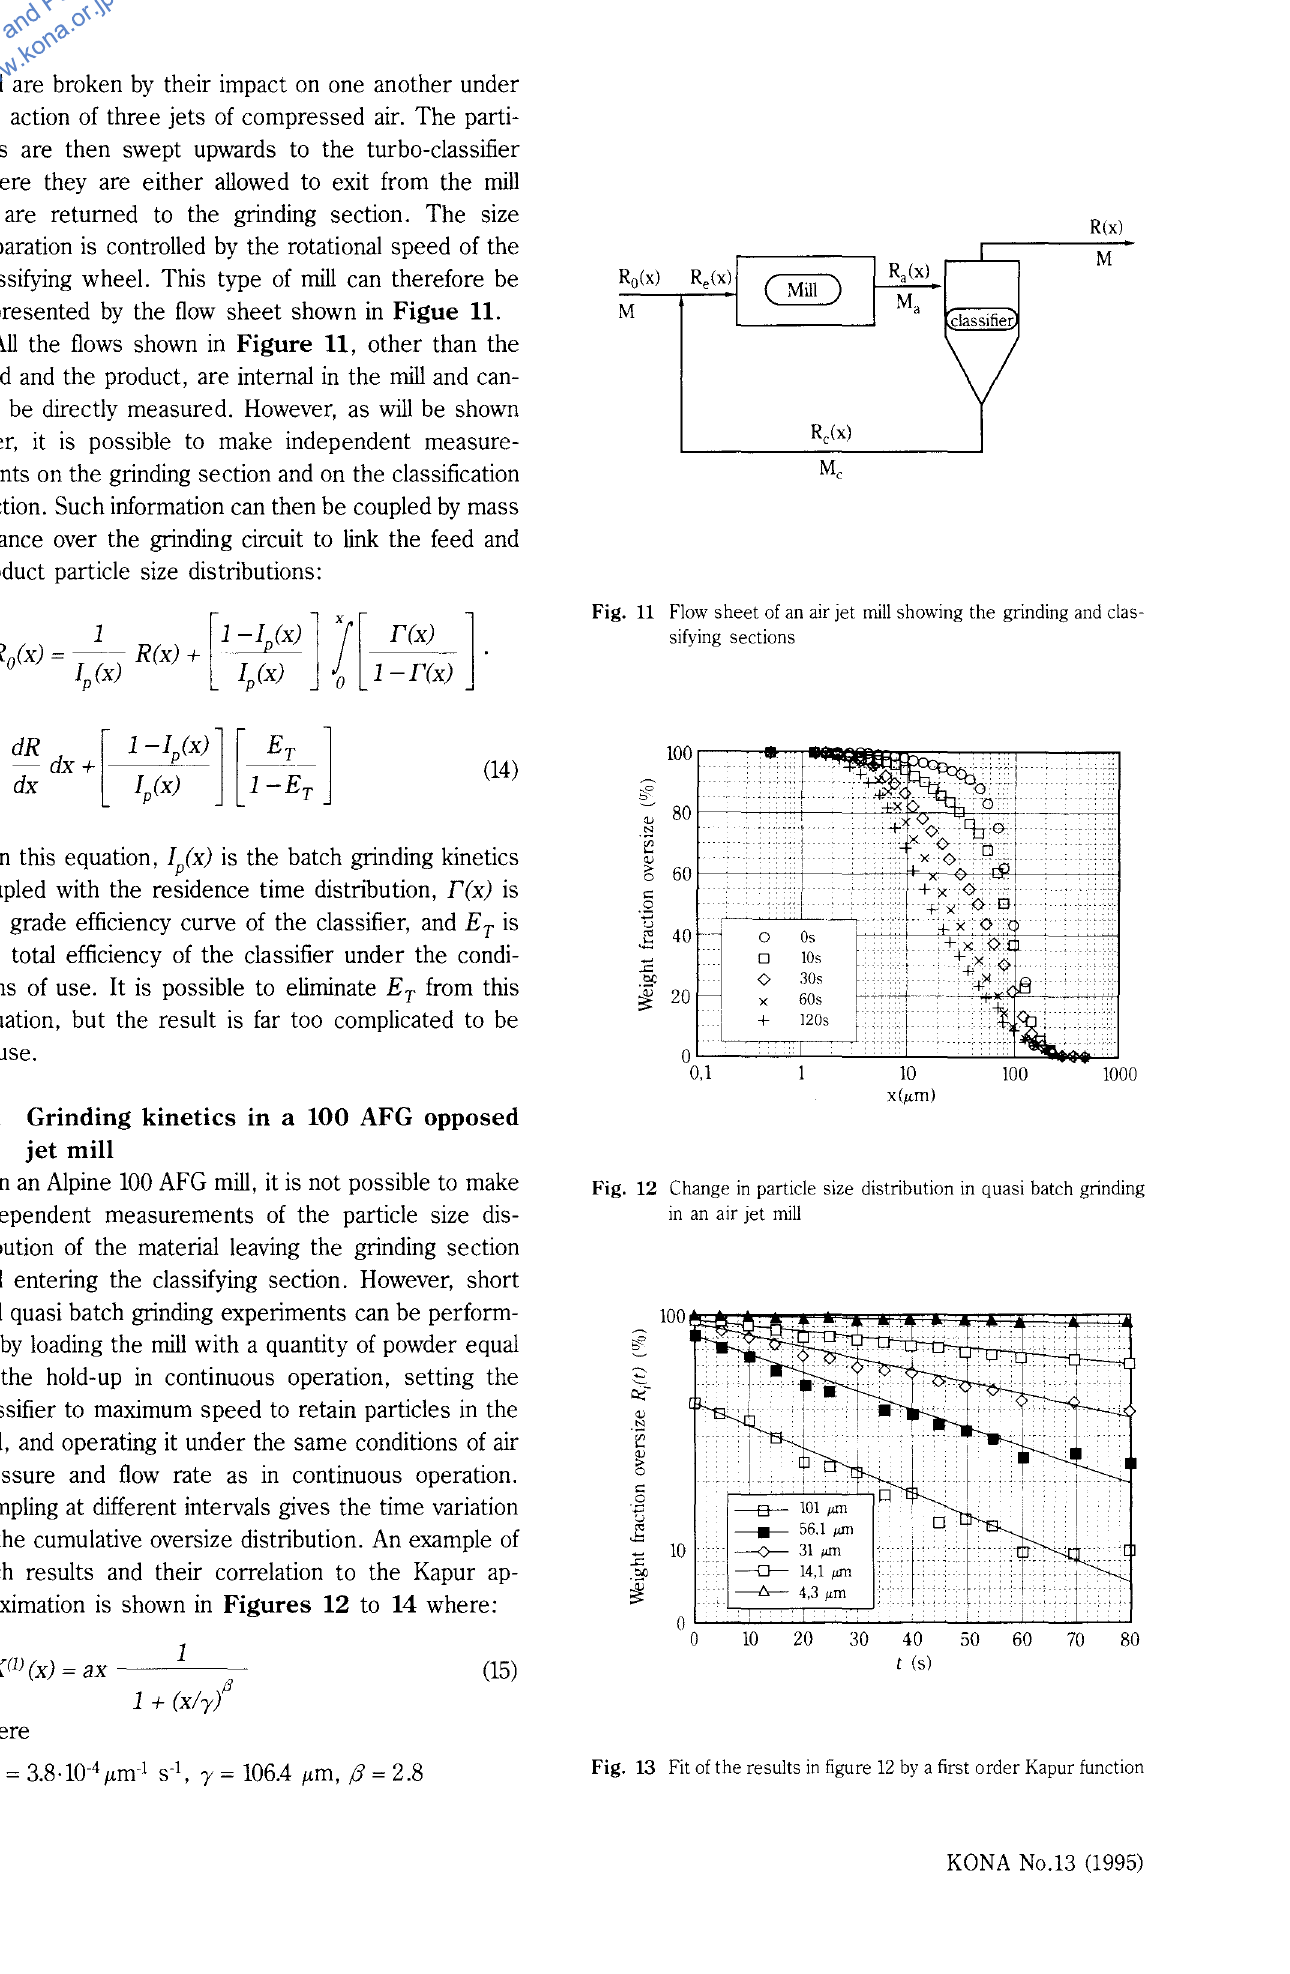
Fig. 13 Fit of the results in figure 12 by a first order Kapur function